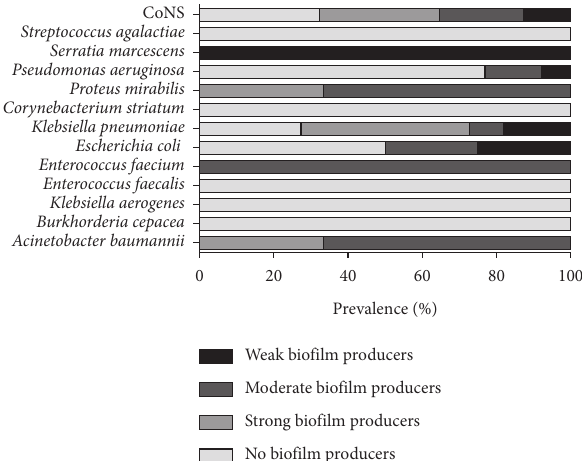
Figure 4: Biofilm formation among MD